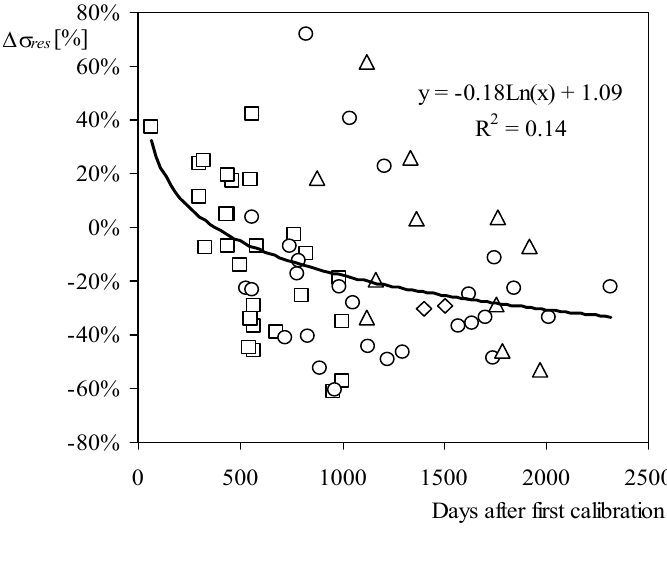
Figure 10. Variation of the standard deviation of the residuals, σ time elapsed from the initial calibration, with regard to calibrations performed to 27 Risø P2546 anemometers that were not subjected to maintenance. These anemometers were calibrated several times at the IDR/UPM Institute (16 anemometers calibrated 3-times, nine anemometers calibrated 4-times, and two anemometers calibrated 5-times). The symbols indicate second calibration (squares), third calibration (circles), fourth calibration (triangles), and fifth calibration (rhombi). A natural logarithm line has been fitted to the data.